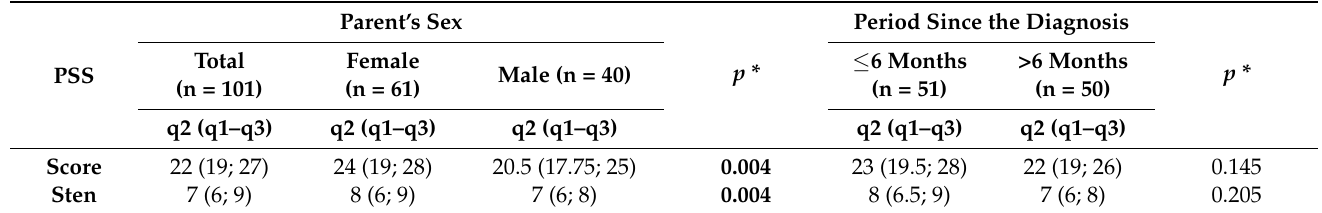
Table 4. The level of parental stress by sex and period since the diagnosis.